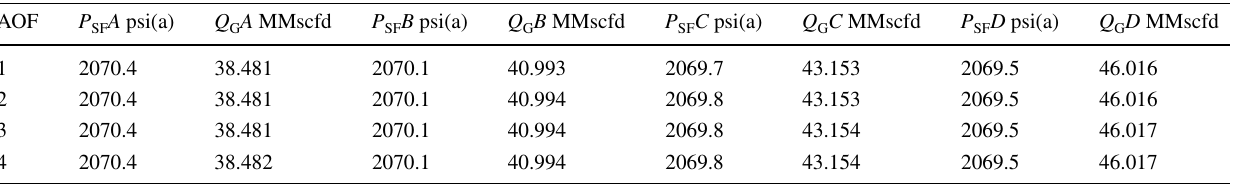
Table 2 Operating points result at reservoir AOF/TPC-type curves analysis for HBJ-06 (pressure vs. flow